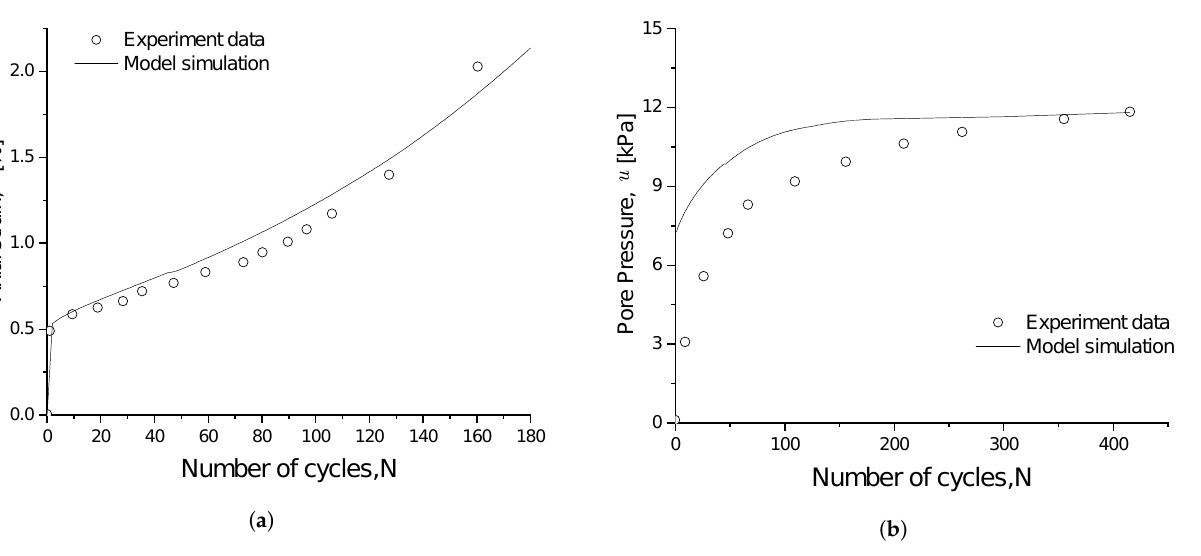
Figure 13. Experimental–numerical comparison of ( a ) axial strain and ( b ) pore pressure evolutions for soft marine clay.